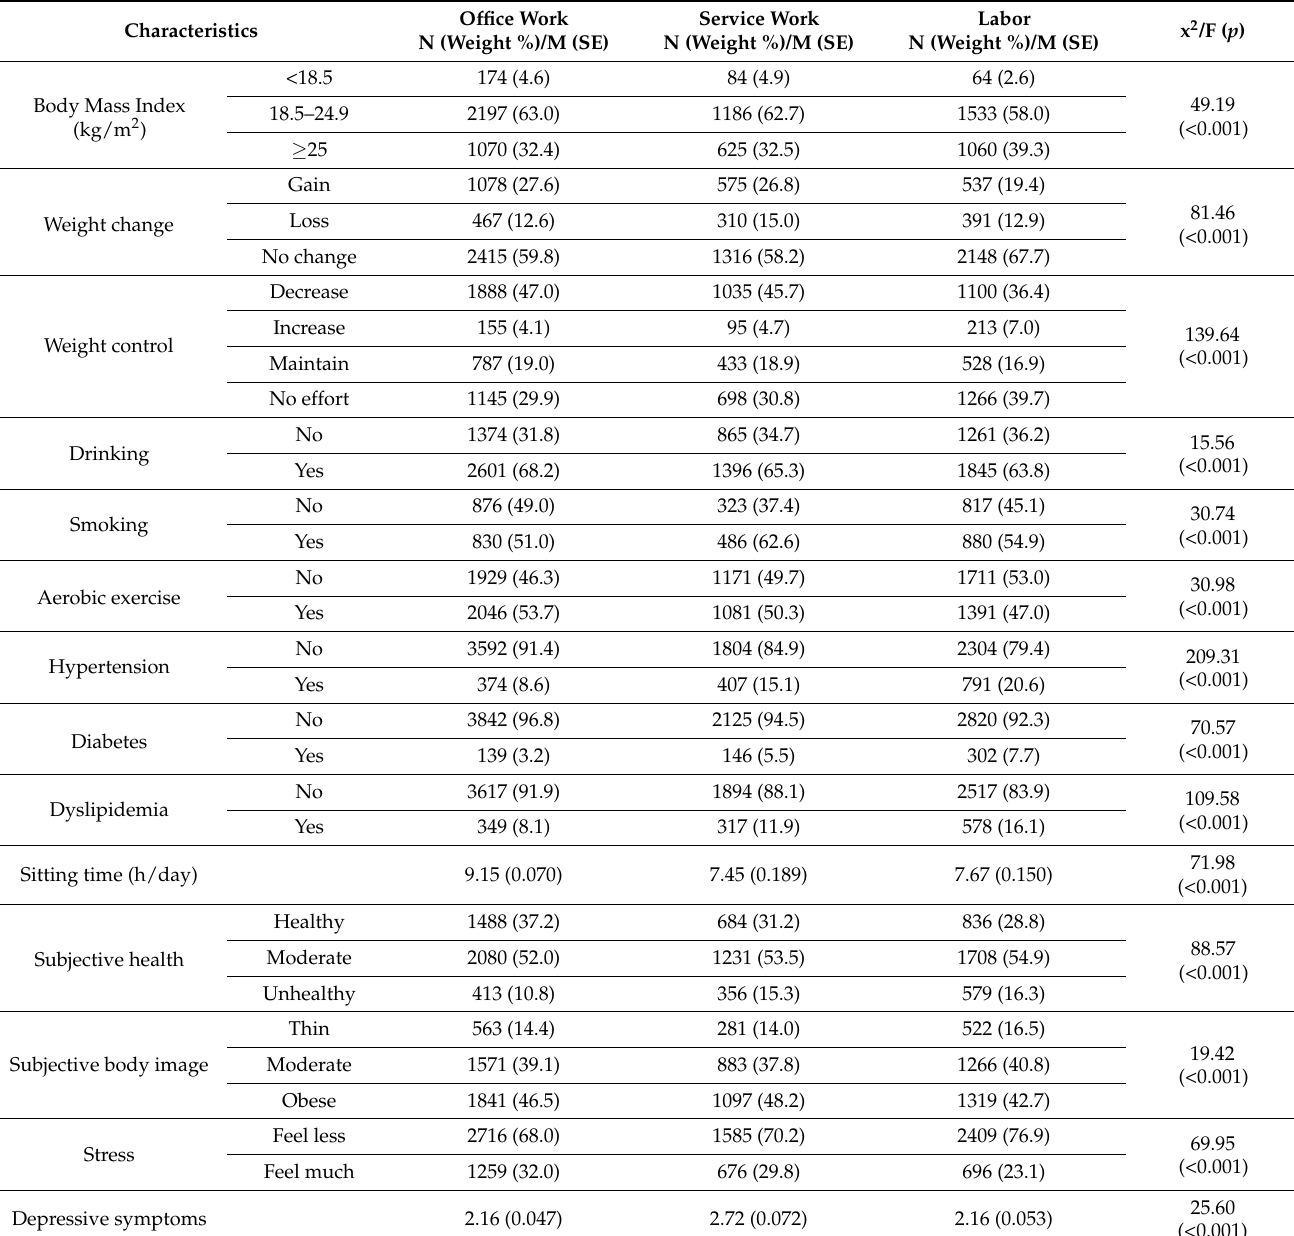
Table 2. Participant physical and psychological characteristics (N =